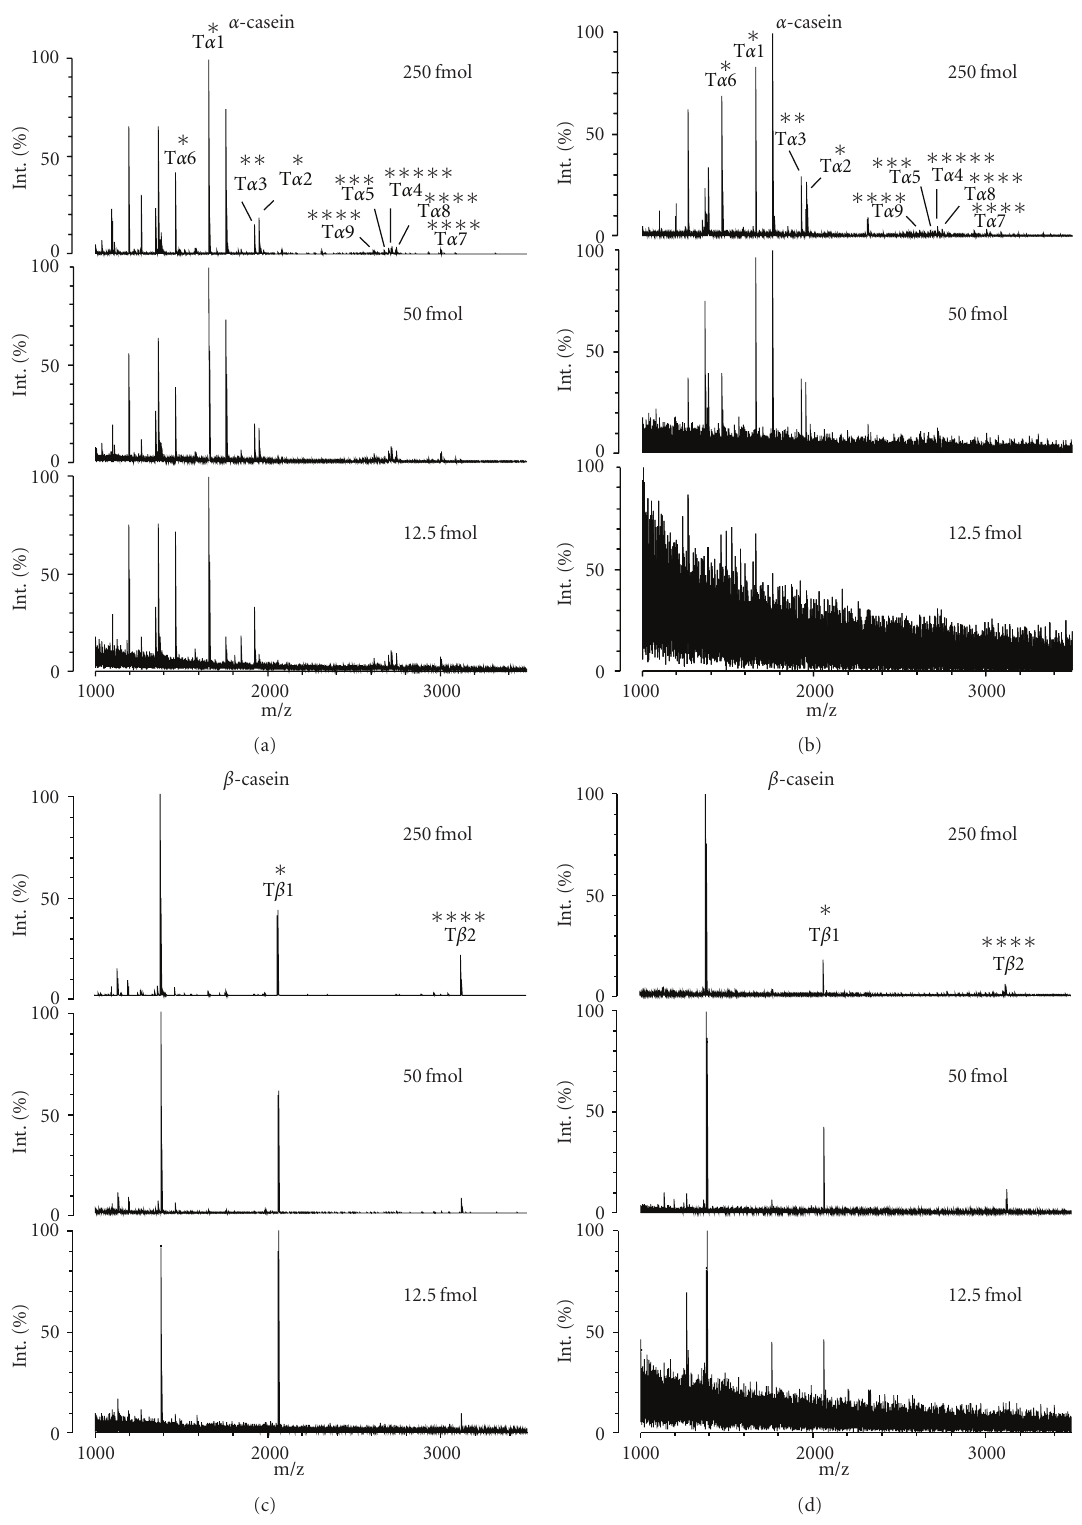
Figure 5: Tryptic digests of α - (upper) and β -casein (lower) (12.5–250 fmol on target) were detected with DHAP/DAHC (a) and (c) and DHB/PA (b) and (d) by MALDI-TOF MS in positive mode. DHAP/DAHC positions were selected randomly in the outer ring of the sample; for DHB/PA, only signals in hot spots were collected. In total, 200 profiles were accumulated for each sample. The number of sites on each phosphopeptide was equal to the number of asterisks ( ∗